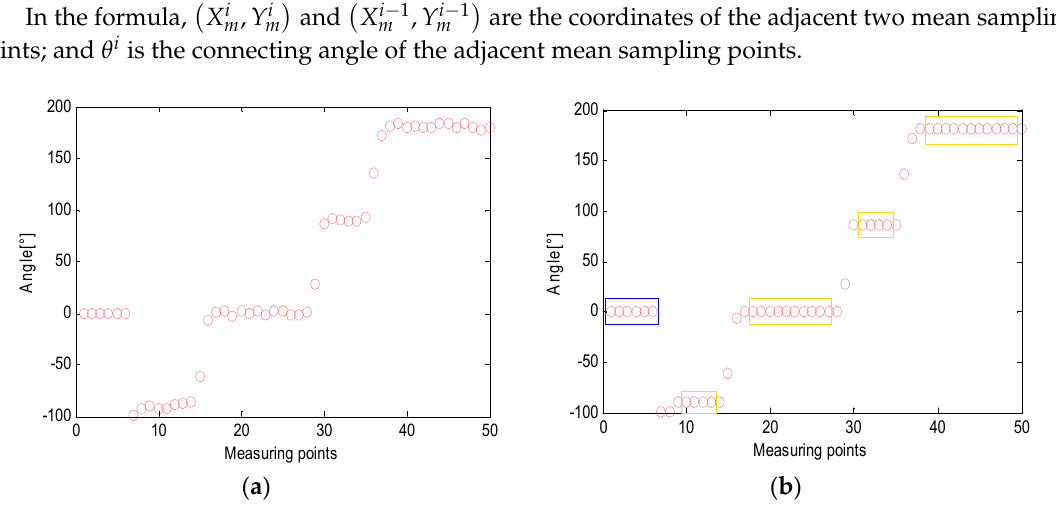
Figure 4. ( a ) Unsmoothed angle information and ( b ) smoothed angle information.